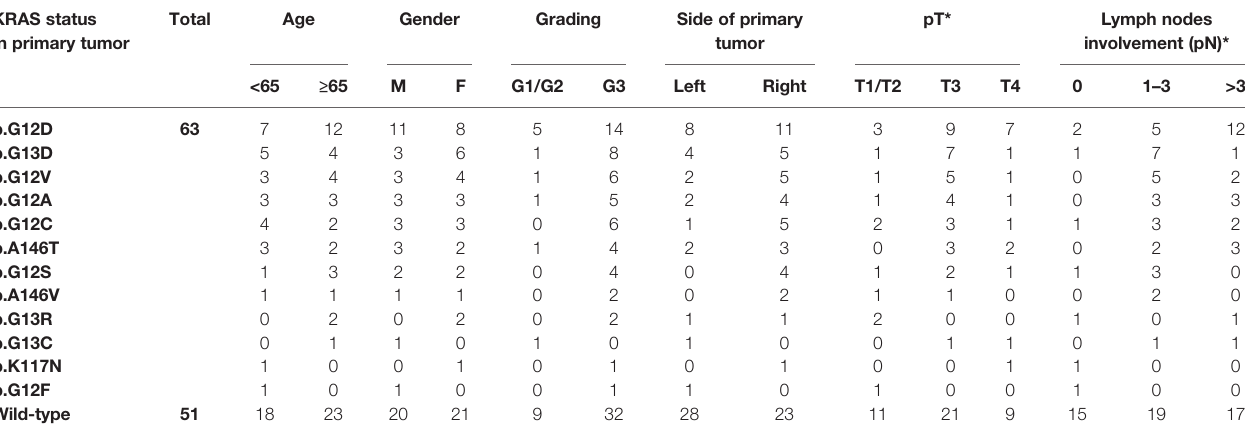
TABLE 1 | Clinico-pathological characteristics according to KRAS status at diagnosis. KRAS status in primary tumor